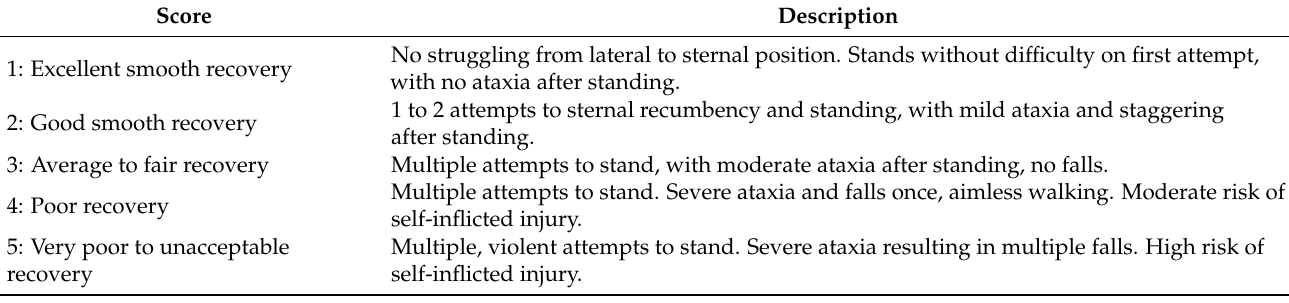
Table A2. Simple Descriptive Scale (SDS).